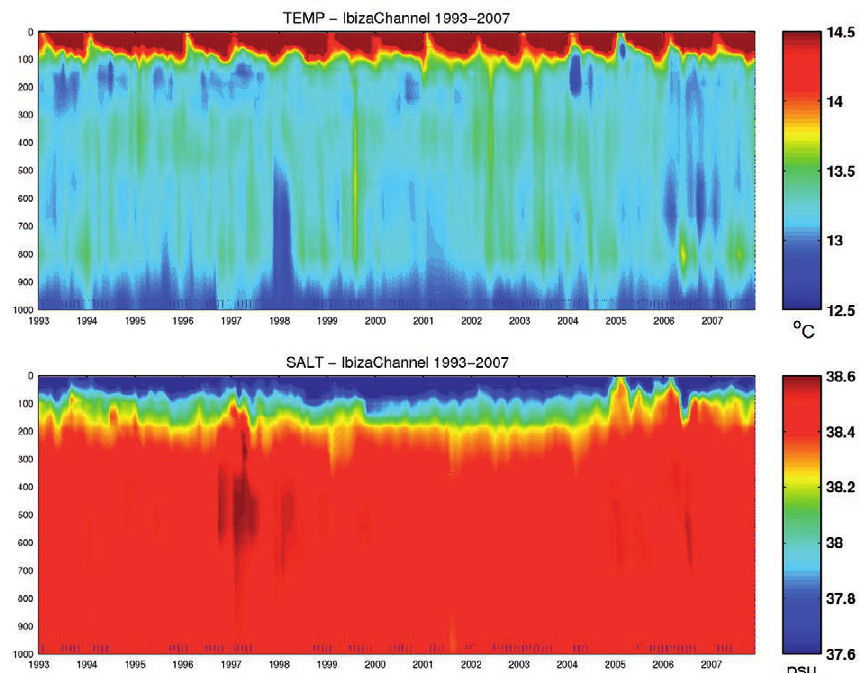
F ig . 9. – Hovmöller diagrams showing the temporal evolution of temperature (top) and salinity (bottom) of a 1° × 1° area at the centre of the Ibiza Channel for the EN3 data. A colour version of this figure may be found in the online electronic